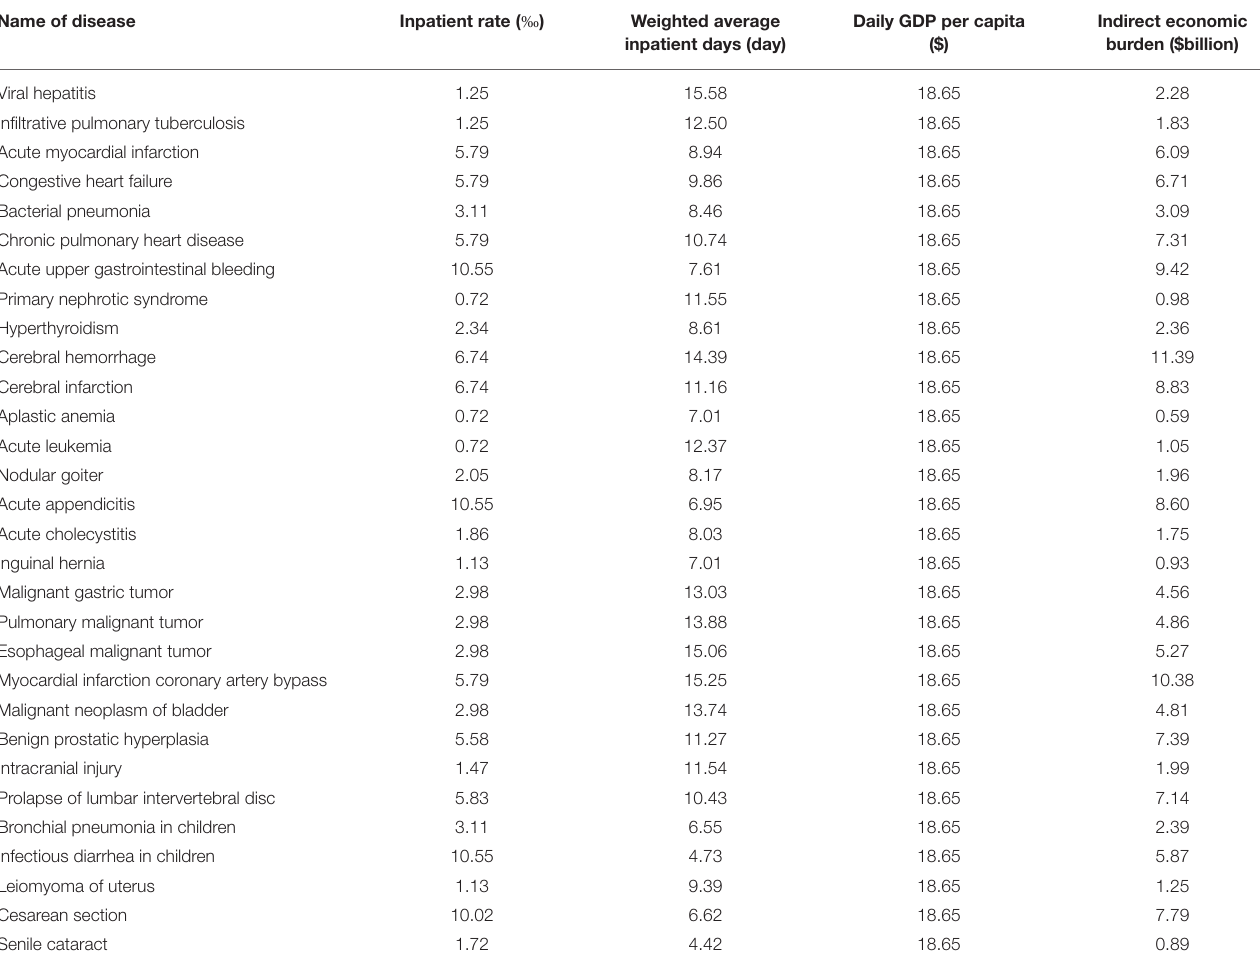
TABLE 4 | Indirect economic burden of 30 types of diseases of rural area in China, 2013. Name of disease Inpatient rate ( ‰ ) Weighted average